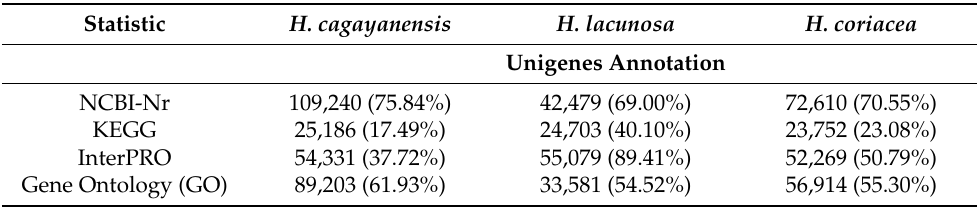
Table 4. A annotated unigenes from flower part of H. cagayanensis , H. lacunosa , and H. coriacea by